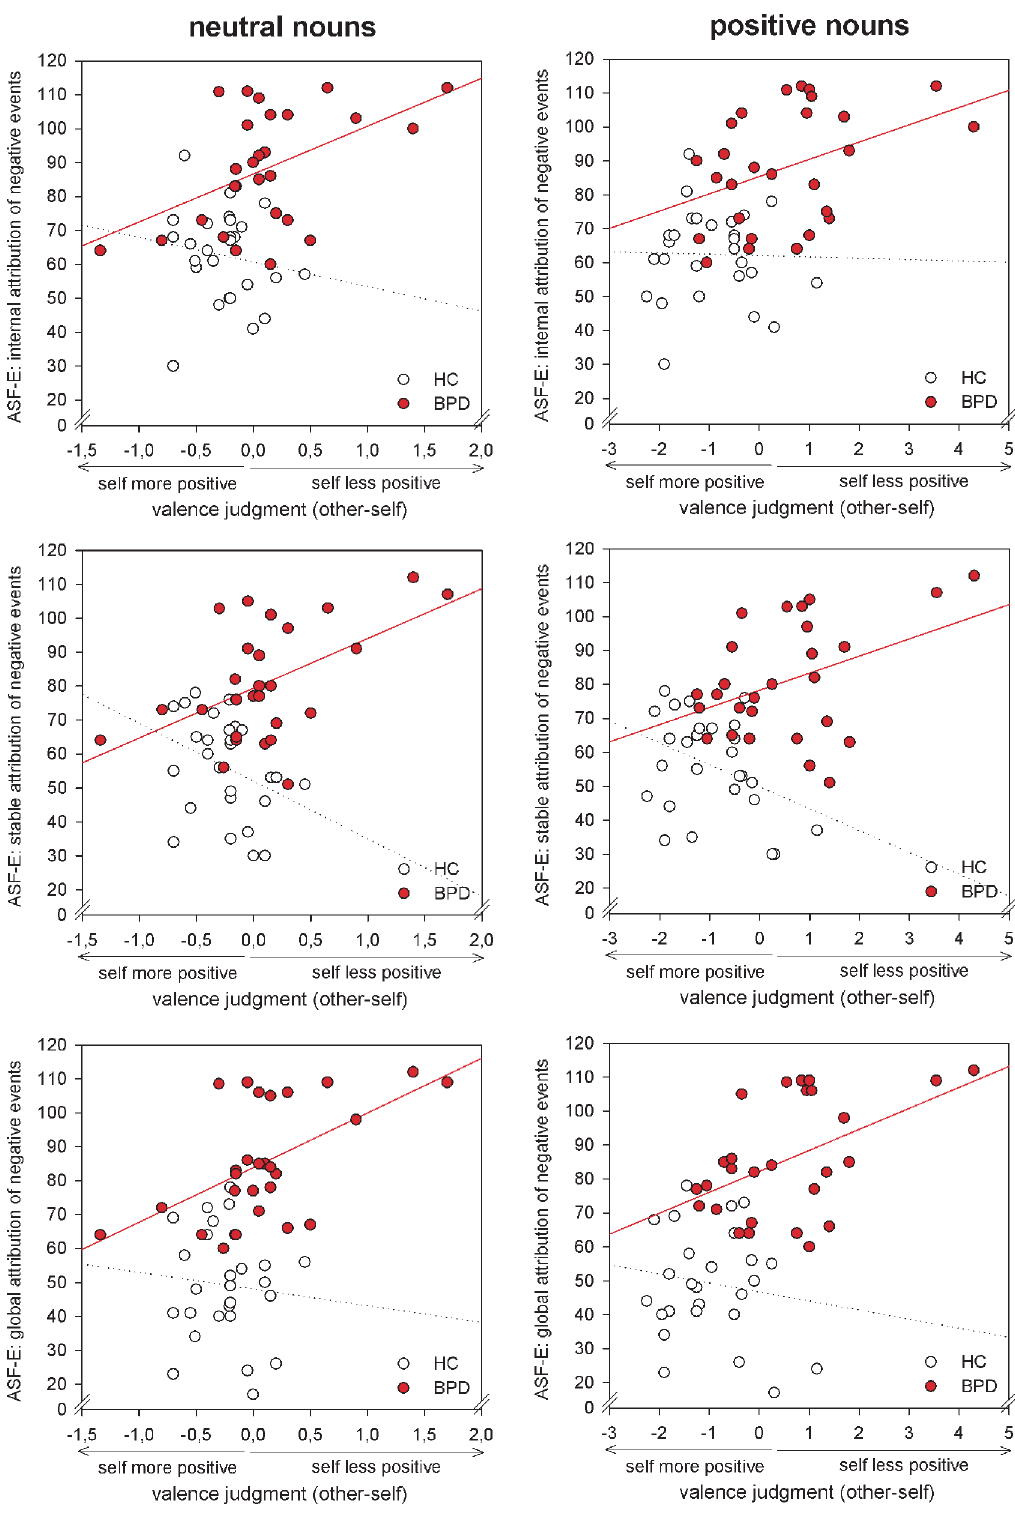
Figure 3. Correlations between self-referential appraisal bias and attributional style. Healthy controls (HC) and patients with Borderline Personality Disorder (BPD) differ in correlations of valence ratings referred to the self in comparison to others and internal, stable and global attributions of negative events for positive and neutral